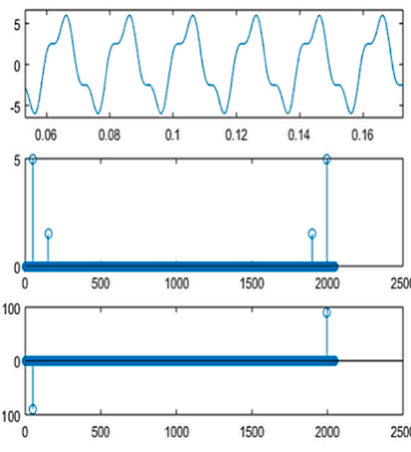
Figure 8. Spectrum of the test signal.